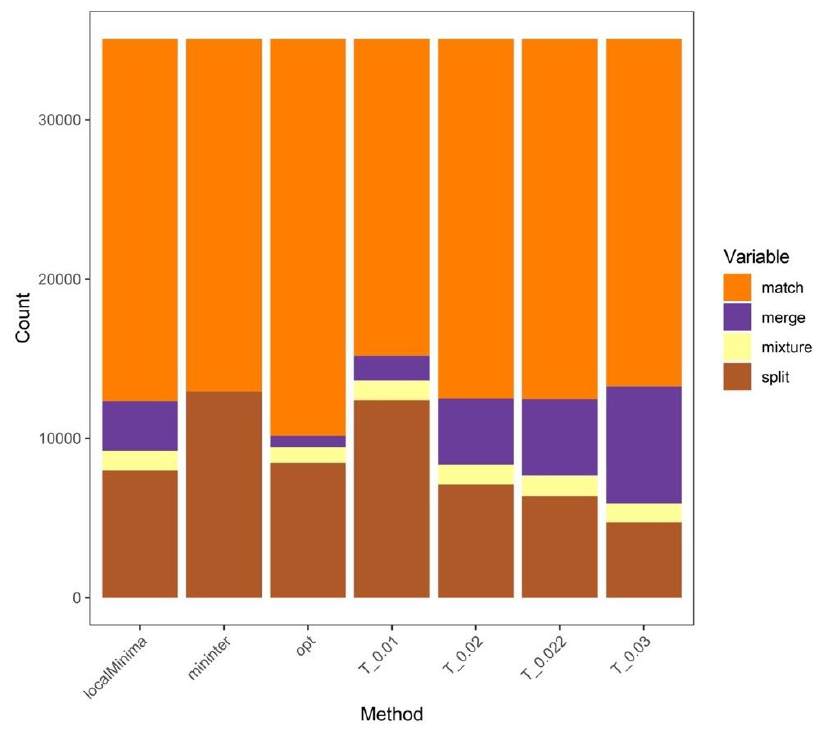
Figure 4. Numbers of “MATCH”, “MERGE”, “MIXTURE”, and “SPLIT” with different methods. T_*: the fixed thresholds of *. mininter: the minimum interspecific genetic distance of congeneric species; localMinima: the possible thresholds from the distance matrix; opt: the optimal thresholds.